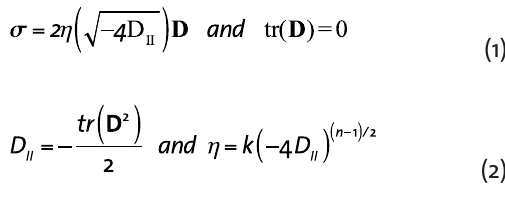
Table 1 (left): Computation of the different constants and characteristic values versus m. Figure 1: Configuration of horizontal dam-break flow at negative